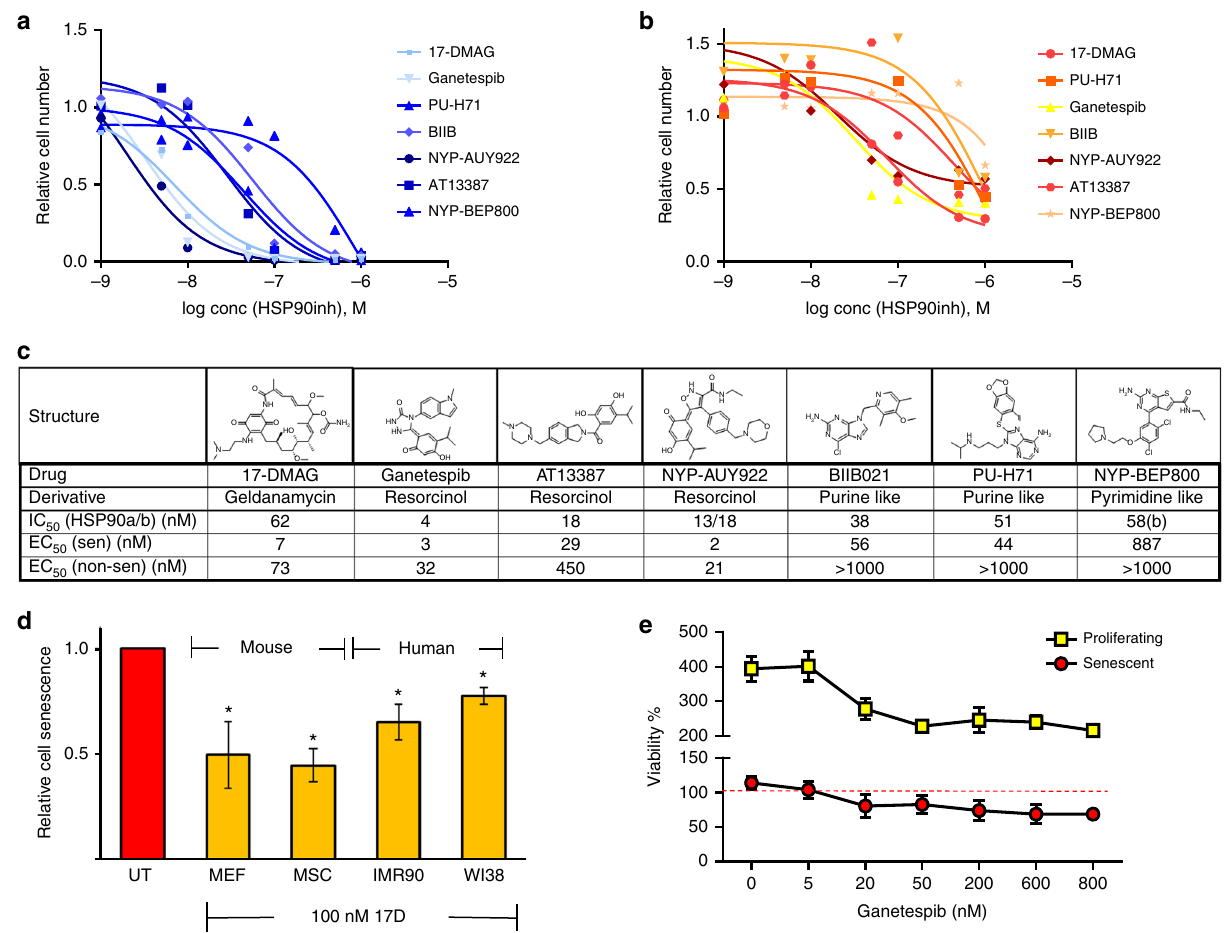
Fig. 6 HSP90 inhibitors (HSP90inhs) are senolytic in two species and multiple cell types. a , b Representative dose response curves of seven HSP90 inhibitors. Eight concentrations (0.1 – 1000 nM) of each drug were tested and plotted against the relative fraction of remaining senescent a and non- senescent passage 5 ERCC-de fi cient MEFs b to determine their senolytic and cytotoxic potential. c Structure, origin, and IC 50 (HSP90a/b inhibition) of